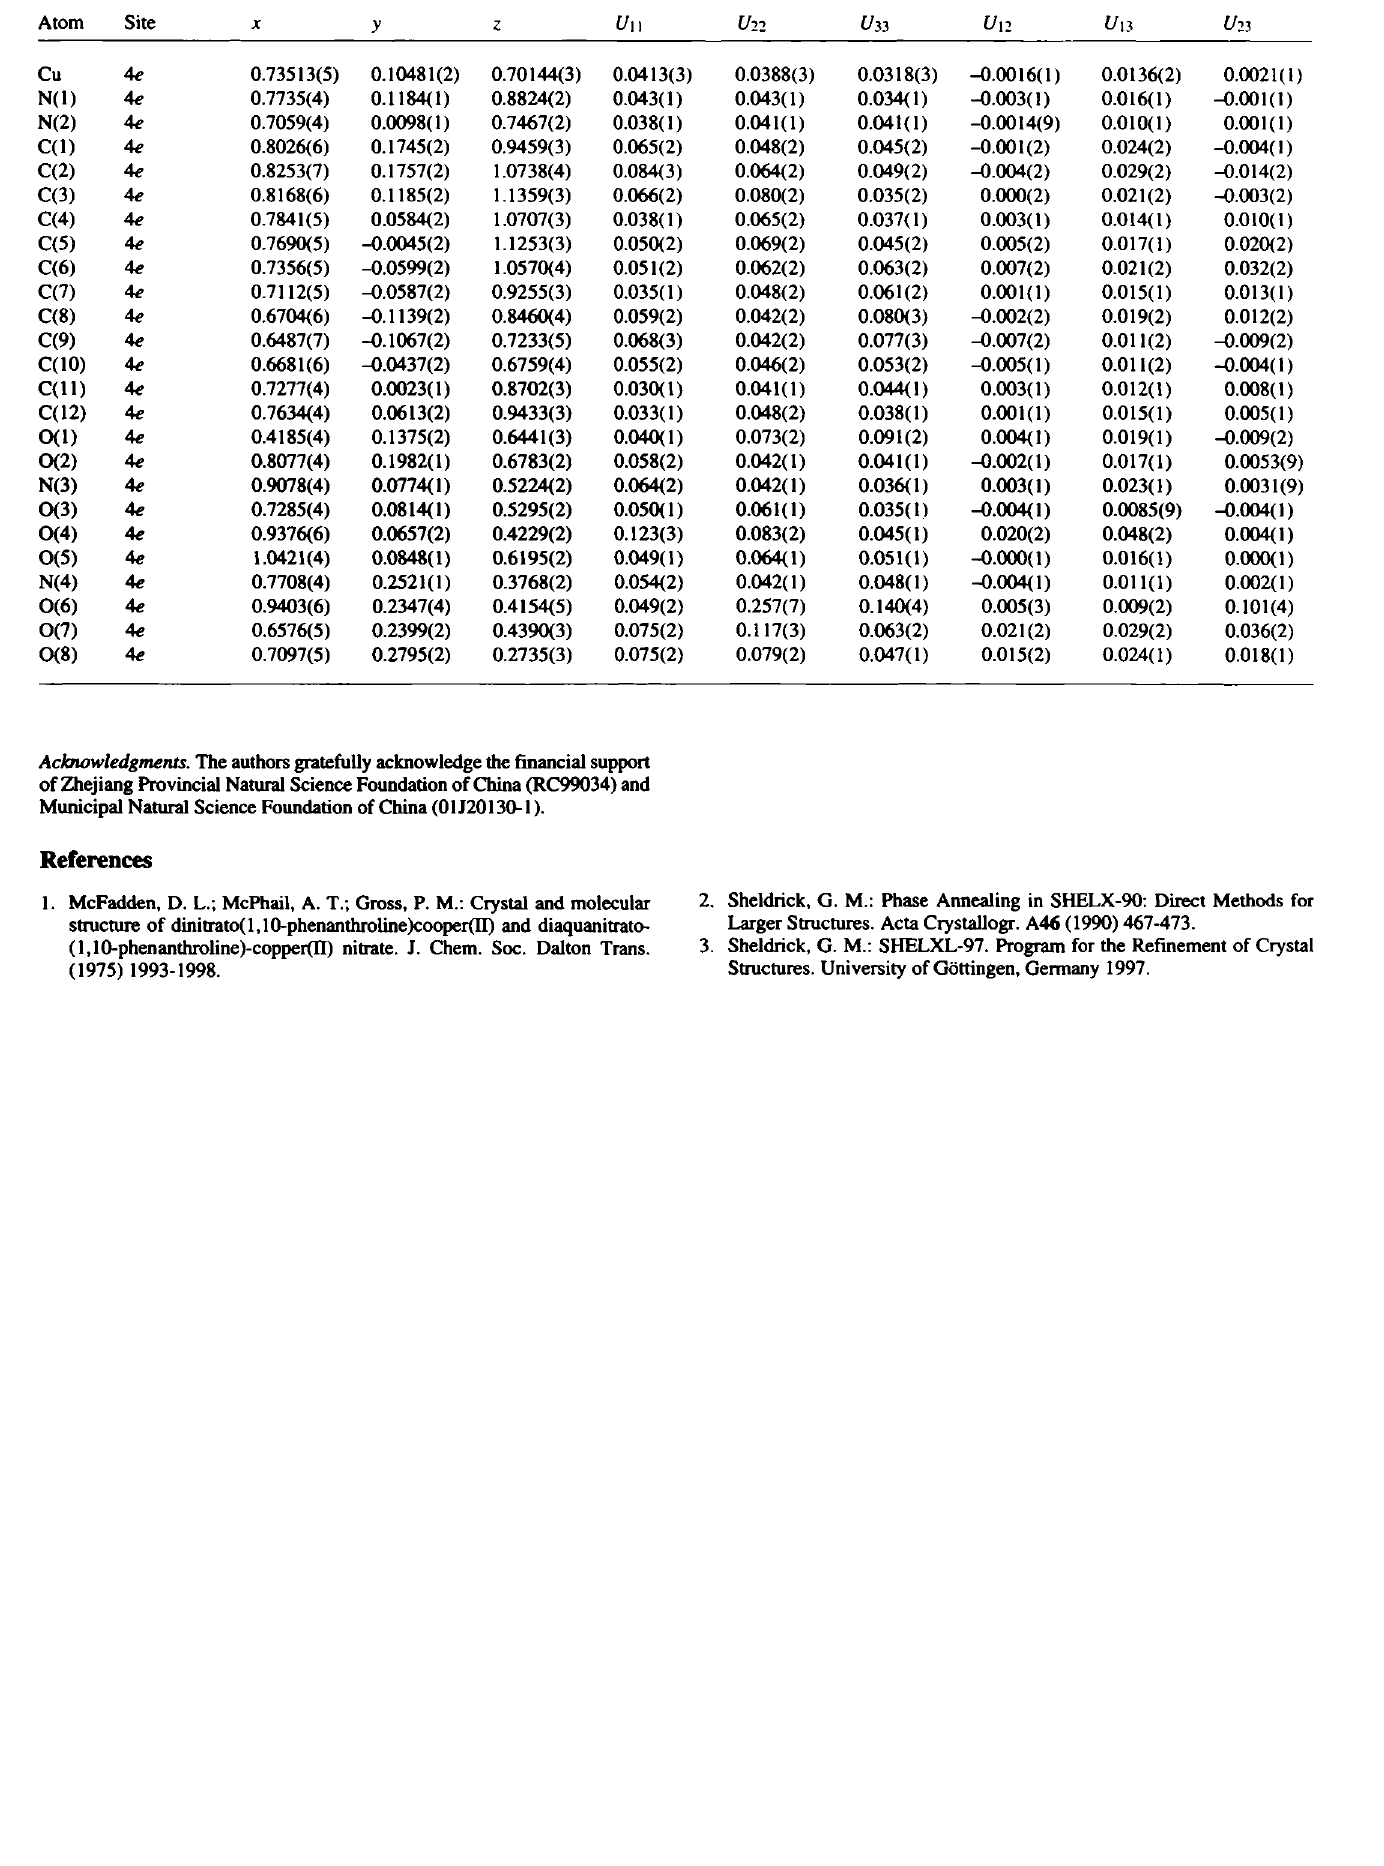
Table 3. Atomic coordinates and displacement parameters (in Â 2